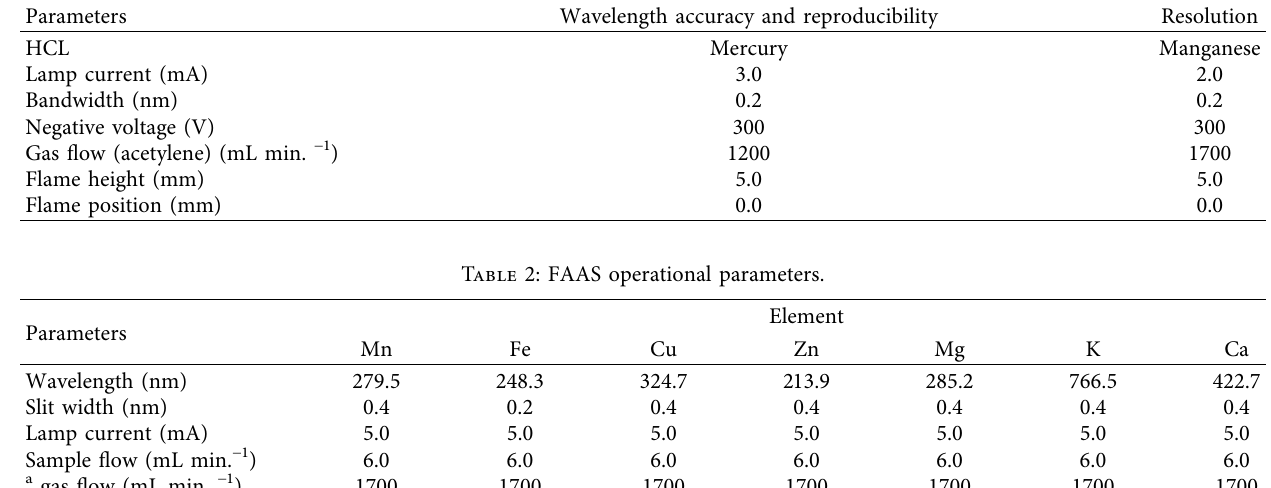
Table 1: FAAS optimization.